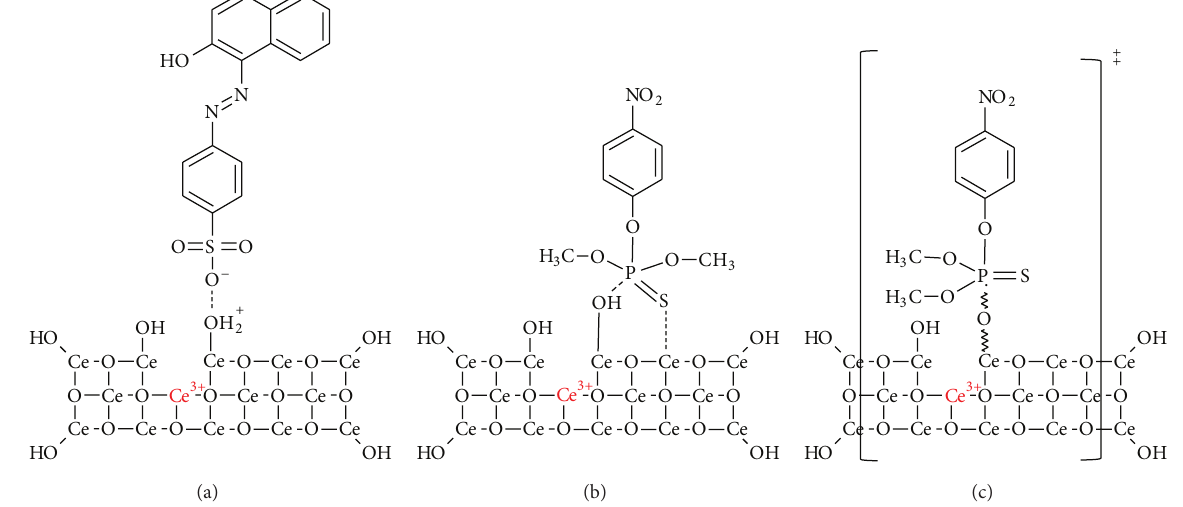
Figure 9: Interaction of AO7 with CeO 2 -surface complexation (a); interaction of parathion methyl with CeO 2 -formation of surface complex (b); interaction of parathion methyl with CeO 2 -nucleophilic attack, transition state (c). Table 4: Parameters of kinetic curves for the degradation of parathion methyl (a) and creation of 4-nitrophenol (b). (a) Degradation of parathion methyl Storage conditions for cerium oxide